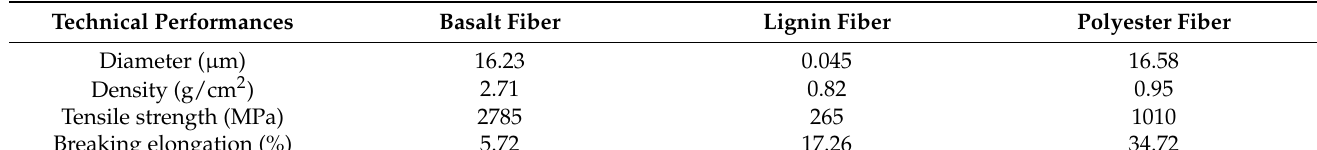
Table 5. Technical performances of fibers.